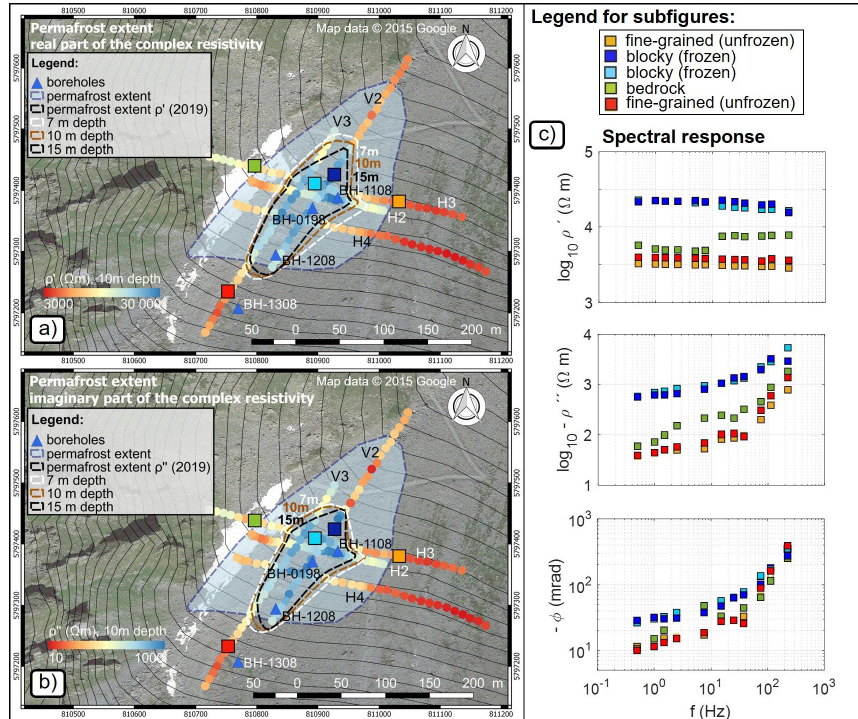
Figure 8. Characterization of the spatial extent of permafrost of the Lapires talus slope for the complex resistivity. The complex resistivity values are expressed as real ρ (cid:48) (a) and imaginary ρ (cid:48)(cid:48) (b) components at 0.5Hz and represent the arithmetic mean at a depth of 10m at each electrode position. Based on the threshold values defined in Fig. 6, the permafrost extent was estimated for each profile for three different depths (7, 10 and 15m), and a spline function was fitted to obtain the white, brown and black dashed lines, which can be compared to the blue polygon (cf. Fig. 1). (c) The spectral responses of ρ (cid:48) , ρ (cid:48)(cid:48) and φ for different locations (coloured squares) in the talus slope (e.g. fine-grained unfrozen, blocky frozen and bedrock